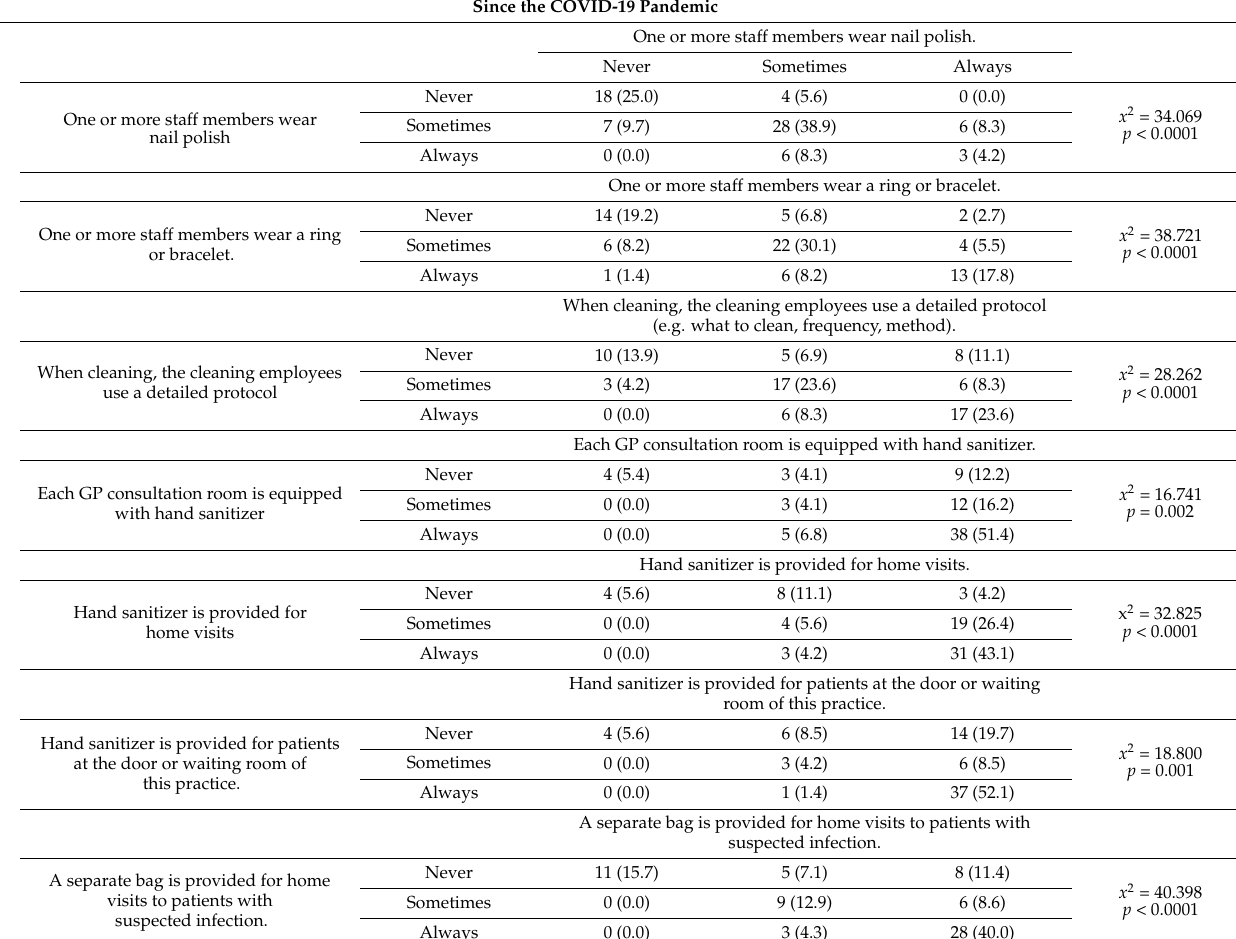
Table 2. Changes on the patient safety and infection prevention measures at the Primary Healthcare Practices in Kosovo.